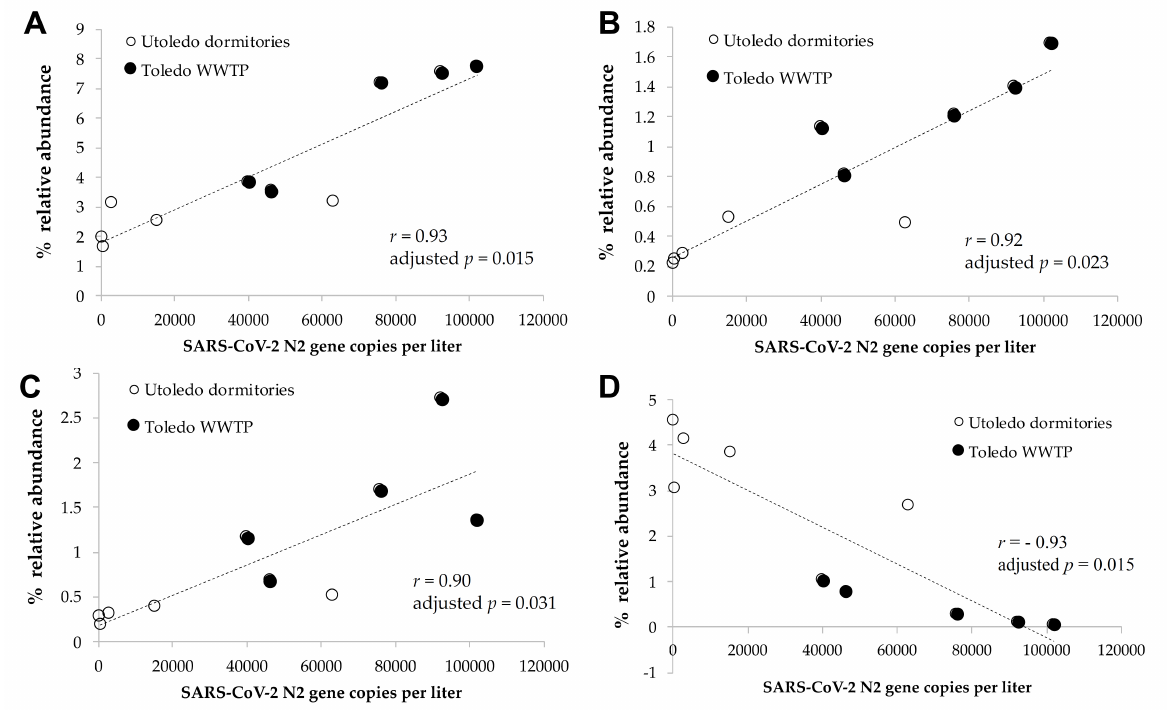
Figure 9. The correlation of SARS-CoV-2 gene copies with microbiome markers. There were signifi- cant correlations between the numbers of SARS-CoV-gene copies and the relative abundances of the bacterial genera ( A ) Blautia , ( B ) Coprococcus , ( C ) Roseburia , and ( D ) unclassified Actinomycetaceae in the wastewater samples (Spearman correlation of r > 0.90, adjusted p <